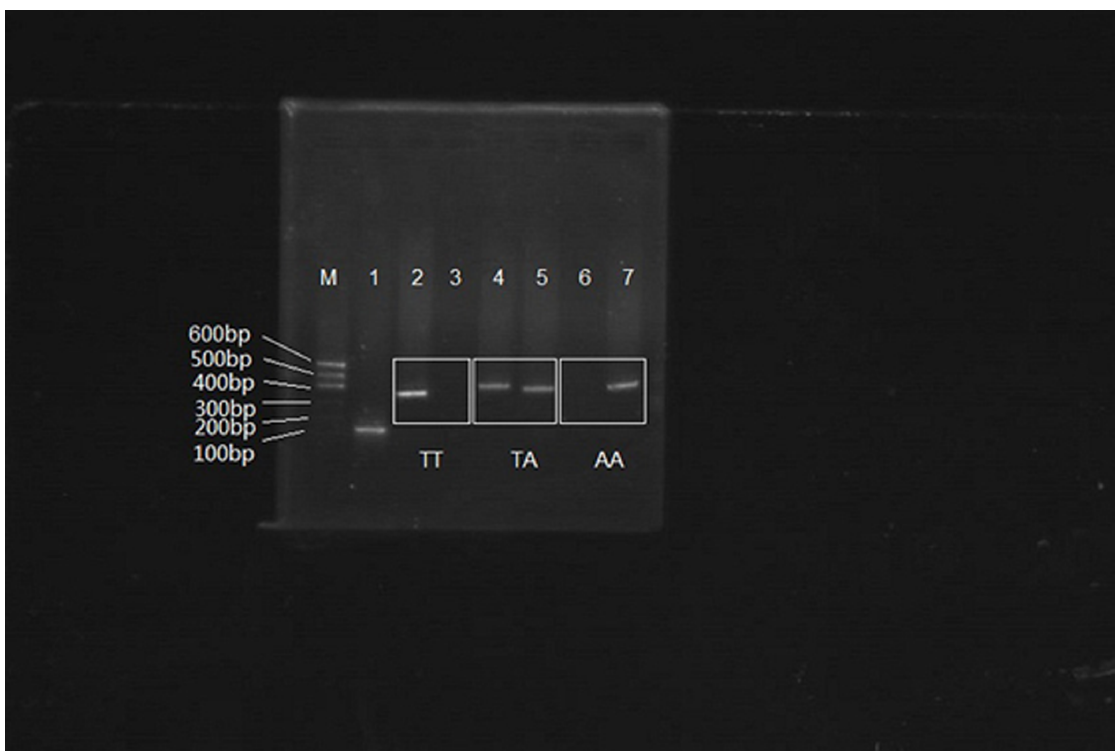
Figure 4. Foxp3-6054 ATT allele in Agarose gel electrophoresis. Lane 1 showed the b -Actin, Lane 2 and 4 showed the positive PCR products amplified by group del primer (F1 primer); Lane 6 showed the negative PCR products amplified by group del primer. Lane 5 and 7 showed the positive PCR products amplified by group ATT primer (F2 primer); Lane 3 showed the negative PCR products amplified by group ATT primers; Lane M: DNA